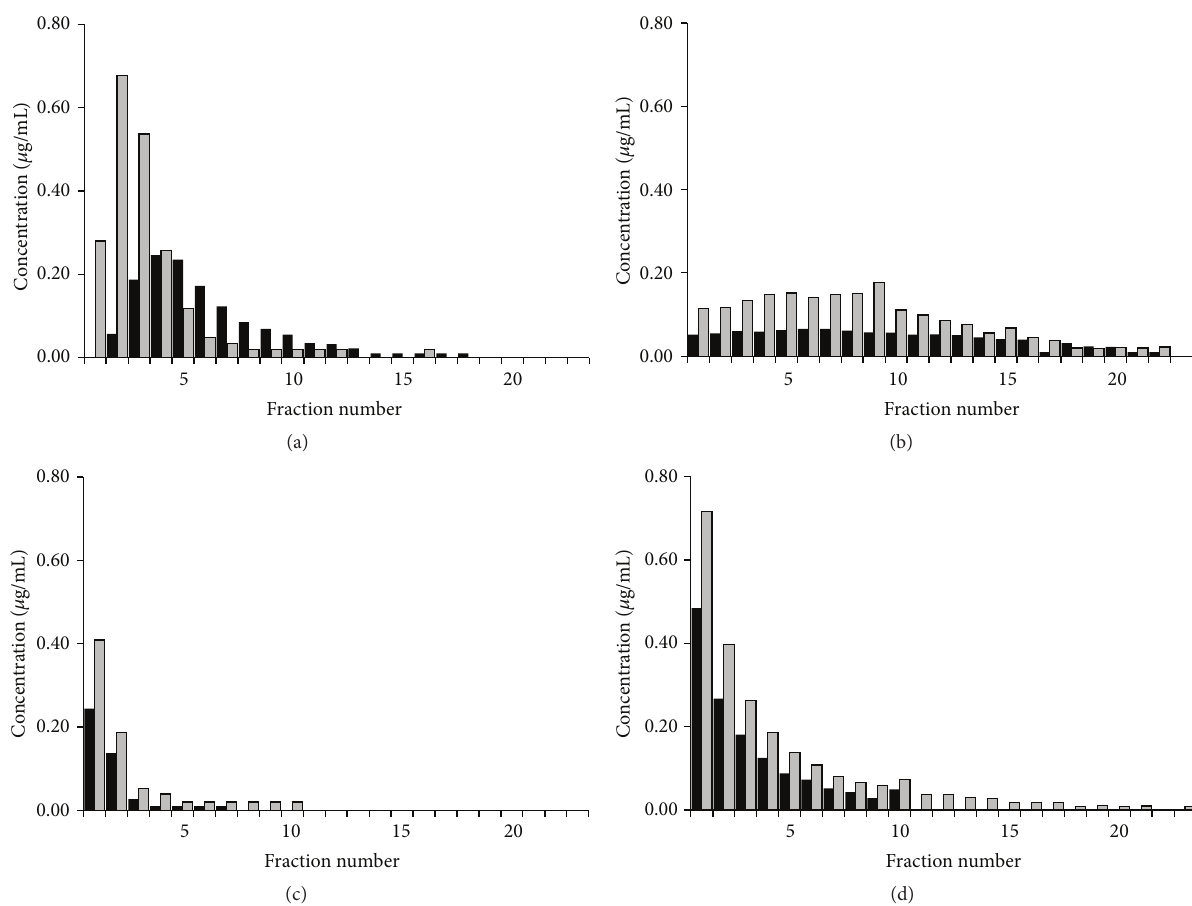
Figure 3: Elution profiles of CLO and TMX upon absorption on soils. Concentrations of CLO (black columns) and TMX (grey columns) measured in aqueous eluates from soil columns of sand (a), clay (b), and loam (c) soils. Eluates from pumice columns (d) are shown as control. Concentrations in 10mL fractions of the eluate are shown in 𝜇 g/mL, as a function of the fraction number.